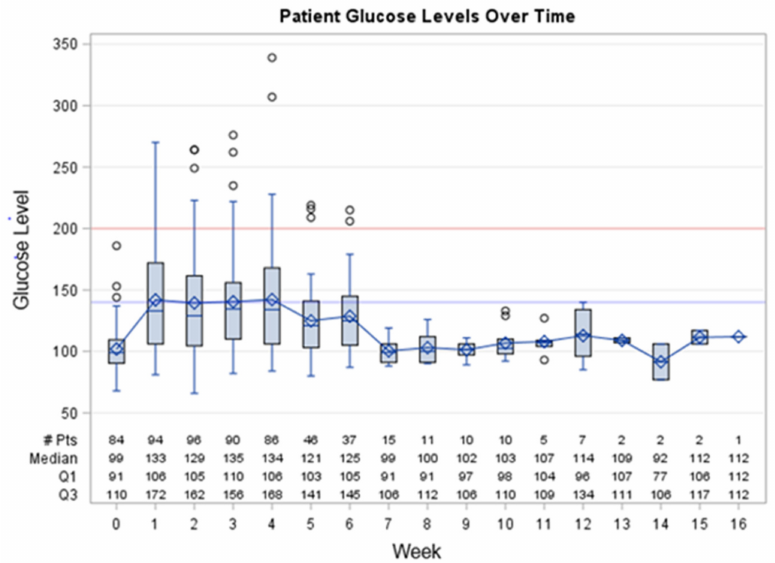
Figure 1. Median blood glucose levels from dexamethasone initiation at week 0 to treatment com- pletion at week 16 (chemotherapy cycle 1 through cycle 4). Overall changes in blood glucose for all patients are reported by cycle and are expressed as the median and IQR, including outliers. Values inside box range from lower to upper quartile; whiskers are drawn from the box to the most extreme point that is ≤ 1.5 × IQR; observations outside this range are plotted individually. Glucose level of 200 is indicative of diabetes. IQR: interquartile range; # pts, number of